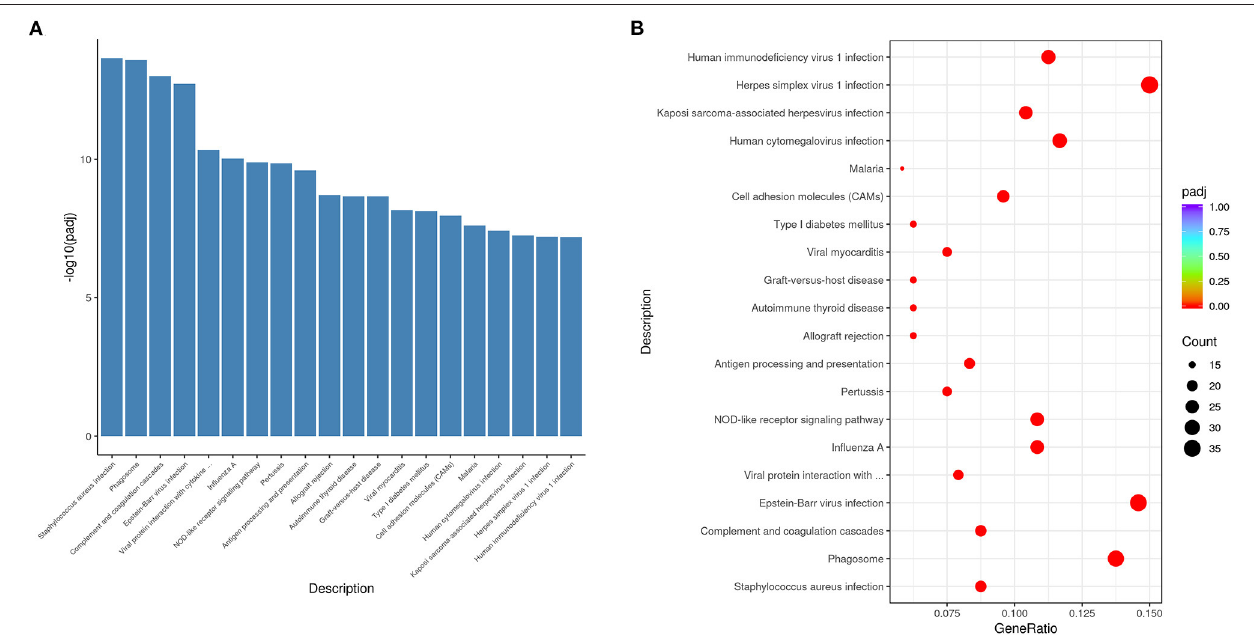
FIGURE 5 | KEGG pathway analysis indicates that the differentially expressed genes altered by VO are principally associated with immune response. (A) Histogram of the 20 most significant KEGG pathways. The 20 most significant KEGG pathways from the KEGG enrichment results are displayed. The abscissa is the KEGG pathway, and the ordinate is the significance level of pathway enrichment; the higher the value, the greater the significance. (B) Scatterplot of the 20 most significant KEGG pathways. The abscissa is the ratio of the number of genes in the KEGG pathway analysis to the total number of differentially expressed genes, the ordinate is the KEGG pathway, the size of the dots represents the number of genes annotated to the KEGG pathway, and the colors from red to purple represent the significance level of KEGG pathway enrichment.